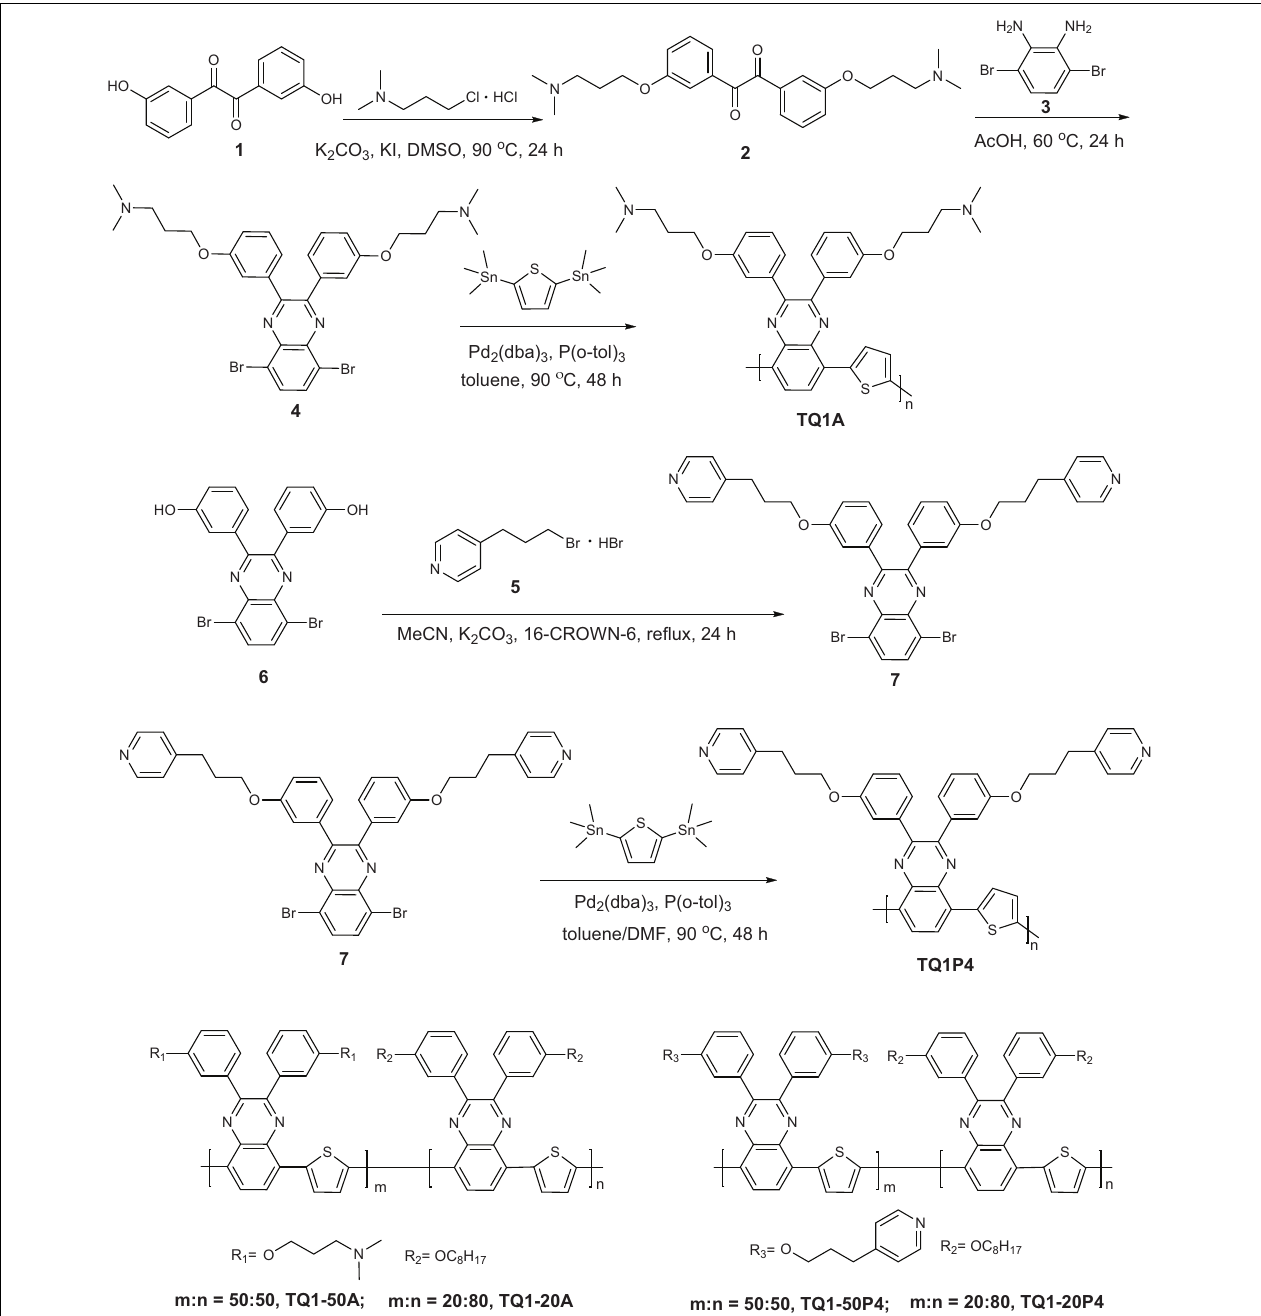
SCHEME 1 | Synthetic route for polymers with amino side groups and pyridine side groups.